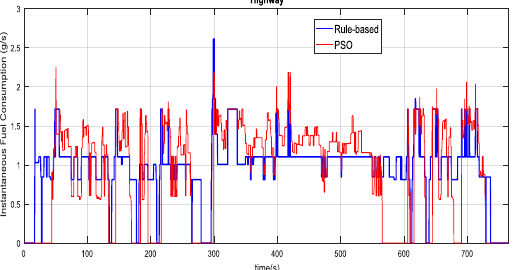
Figure 11. Comparison of instantaneous fuel consumption in the highway driving cycle.